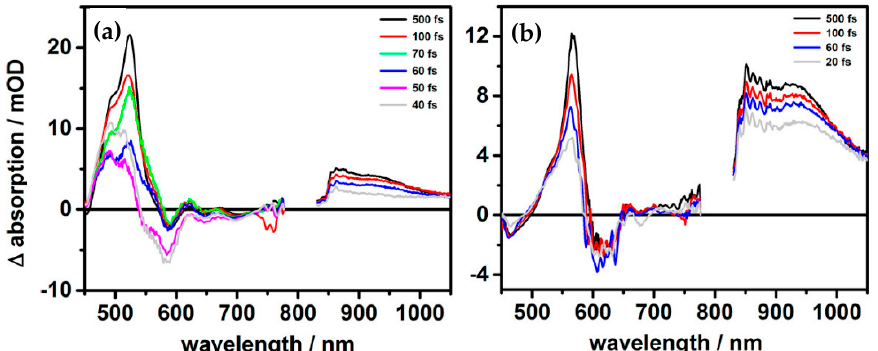
Figure 4. Transient absorption spectra at several probe delay times for ( a ) TIPS–Pn and ( b ) Diaza– TIPS–Pn. Reprinted with permission from Ref. [77]. Copyright 2014, American Chemical Soci- ety.